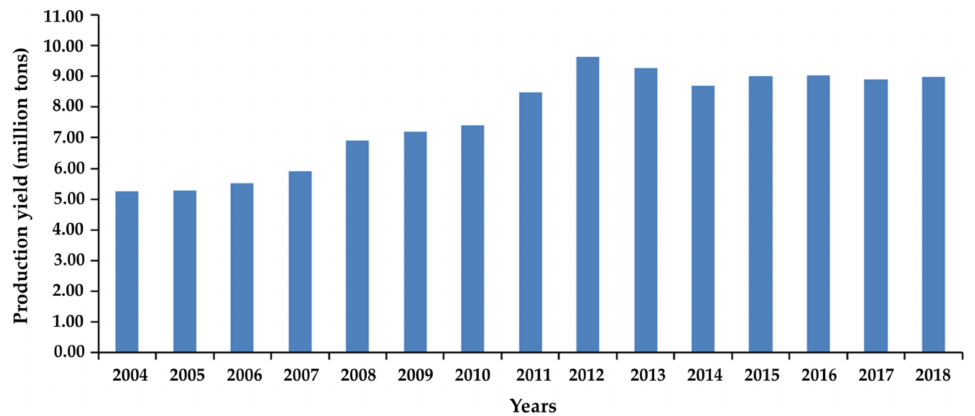
Figure 2. Data of global mushroom production during 2004–2018 from FAOSTAT